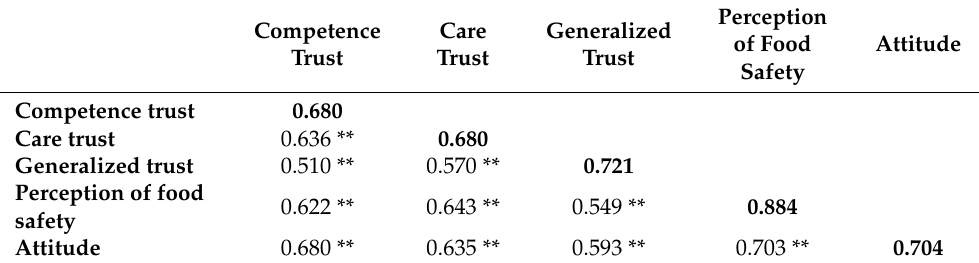
Table 4. Correlation of Latent Variables and Square Roots of AVE.